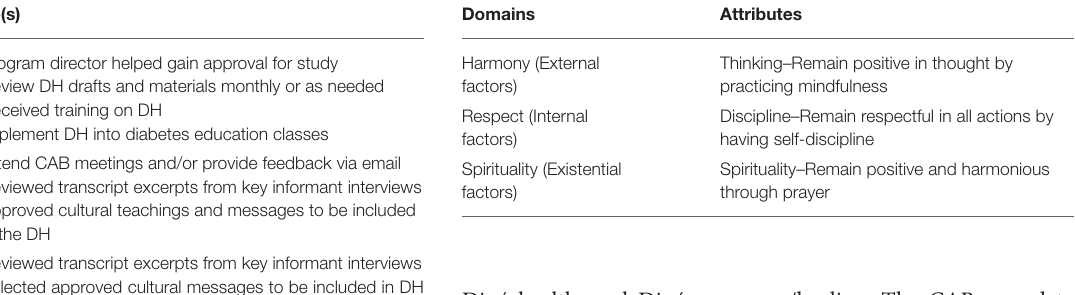
TABLE 1 | Community partnerships and roles in the Diné Health (DH) study. Members